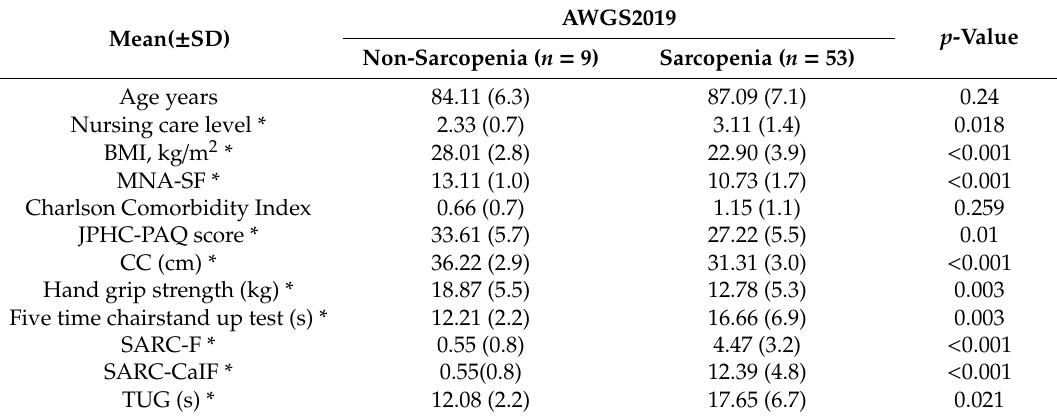
Table 3. Factors associated with sarcopenia.